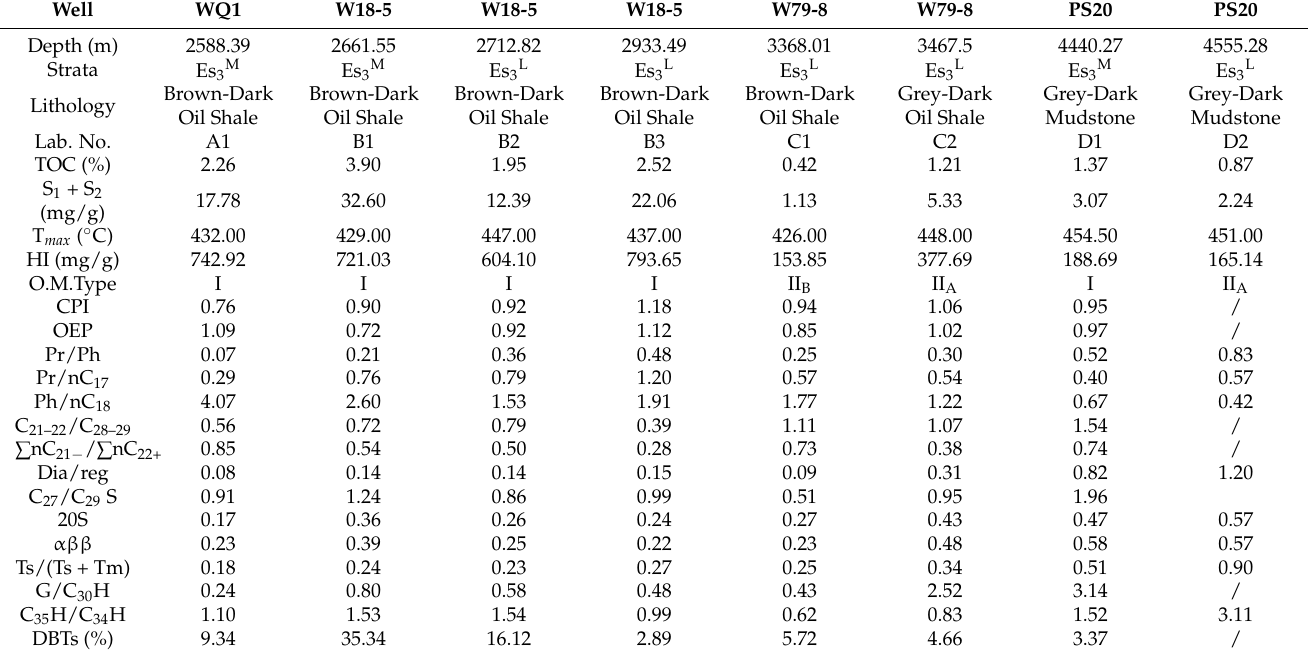
Figure 2. Correlation diagram of the organic carbon and hydrocarbon generation potential of source rocks in the middle and lower members of Es 3 in the Dongpu Depression. Table 1. Conventional geochemical parameters for the source rocks and oil sands that were ana- lyzed.